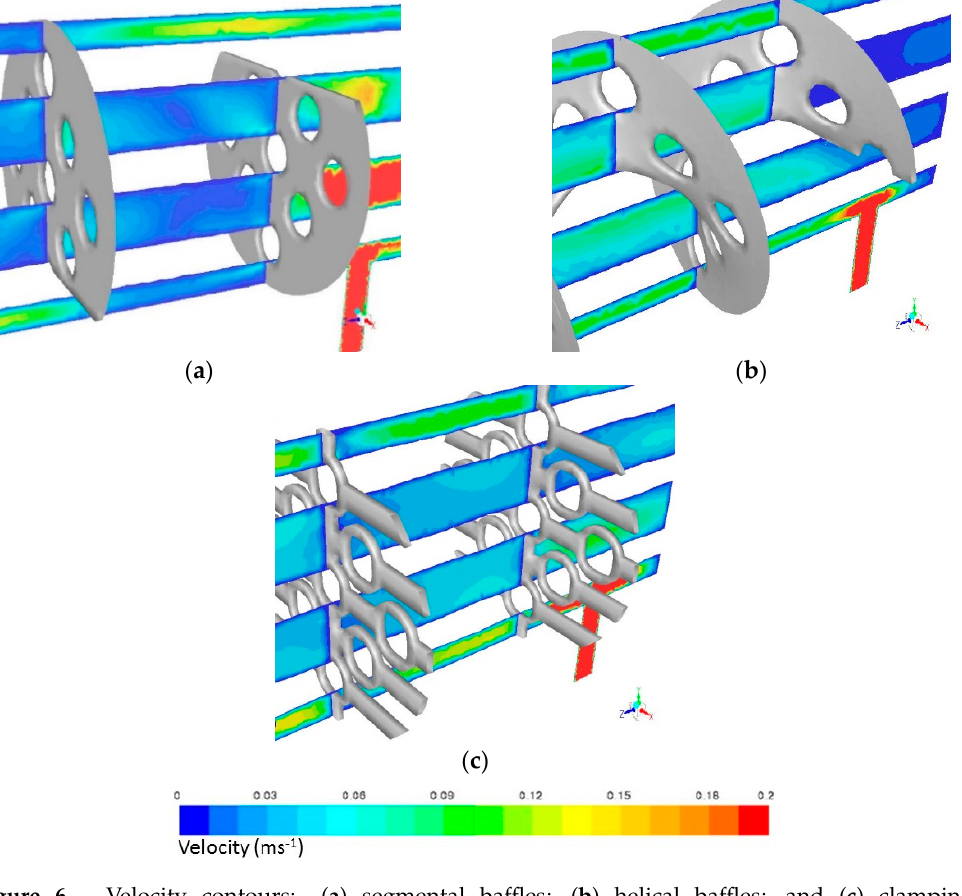
Figure 6. Velocity contours: ( a ) segmental baffles; ( b ) helical baffles; and ( c ) clamping antivibration baffles.